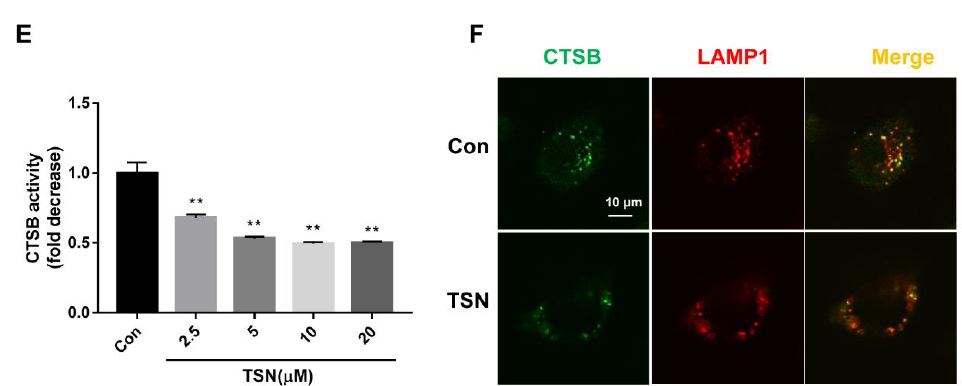
Figure 4. TSN induced lysosome dysfunction in HepG2 cells and L02 cells. ( A ) HepG2 cells and L02 cells were treated with TSN (10 μM), Baf (0.5 μM) , or Rapa (1 μM) for 6 h, then lysosomal acidity was monitored by LTR staining, and the relative LTR fluorescent intensity was quantified. Scale bar: 40 μm. ( B ) HepG2 cells treated with TSN for 6 h at different concentrations (2.5, 5 10, 20 μM) were analyzed by Western blotting for the protein levels of LAMP1, LAMP2, and CTSB. The ratios of LAMP1/GAPDH, LAMP2/GAPDH, and CTSB/GAPDH were calculated using ImageJ software. ( C ) HepG2 cells treated with TSN (10 μM) over a certain time course (0, 6, 12, 24, 36, 48 h) were analyzed by Western blotting for the protein levels of LAMP1, LAMP2, and CTSB. The ratios of LAMP1/GAPDH, LAMP2/GAPDH, and CTSB/GAPDH were calculated using ImageJ software. ( D ) H epG2 cells and L02 cells were firstly incubated with 10 μg/mL DQ -BSA in EBSS medium for 1.5 h and then treated with TSN (10 μM), Baf (0.5 μM), E64D (25 μM) plus pepstatin A (50 μM) ( E + P), and EBSS medium for another 6 h. The relative DQ-BSA fluorescent intensity was quantified. Scale bar: 40 μm. ( E ) HepG2 cells were treated with TSN for 6 h at different concentrations (2.5, 5, 10, 20 μM) , and then CTSB activity was assayed using a CTSB Activity Assay Kit (Fluorometric). ( F ) HepG2 cells were treated with or without TSN (10 μM) for 6 h, and then cellular immunofluorescence staining was used to detect the colocalization of CTSB and LAMP1. Scale bar: 10 μm. Data are presented as the mean ± SD of three independent experiments. ** p < 0.01 versus control.